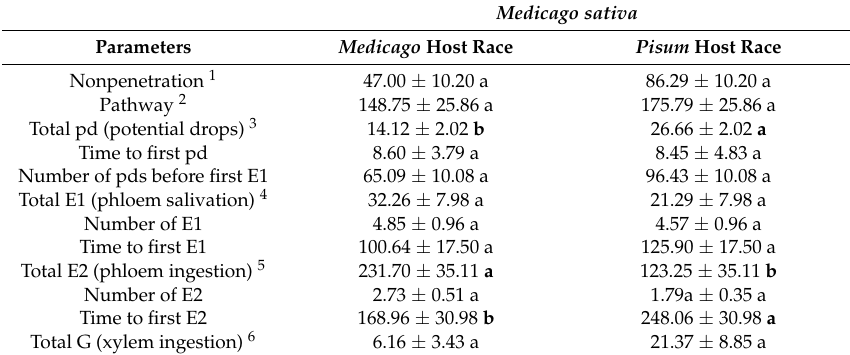
Table 1. The feeding behavior of the two host races of Acyrthosiphon pisum when fed on Medicago sativa